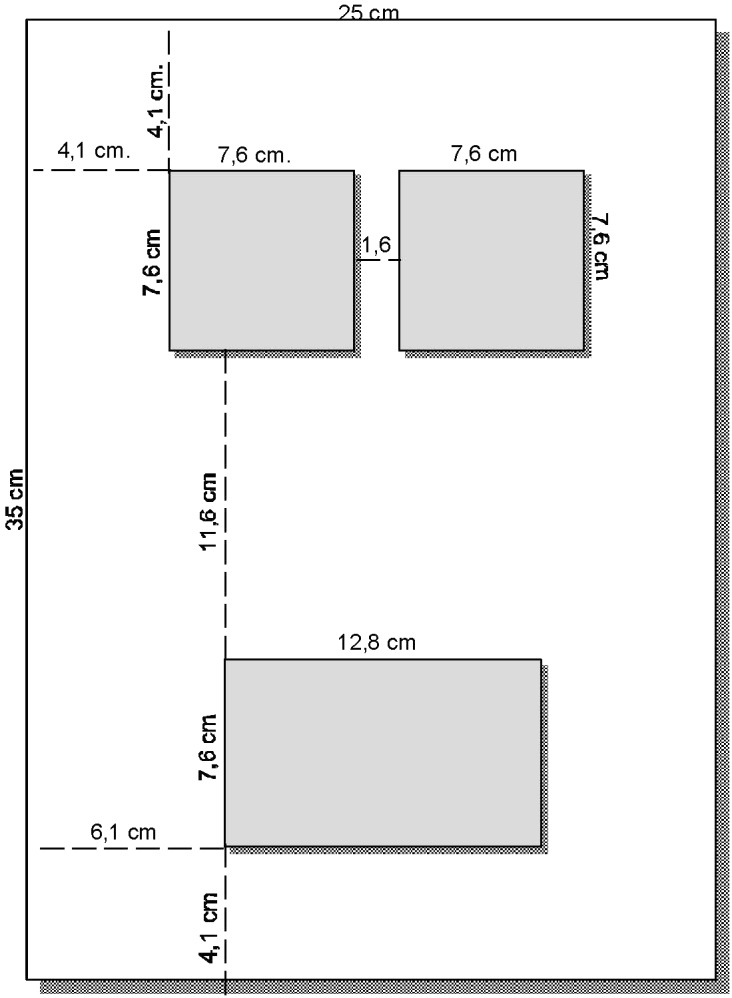
The response board.